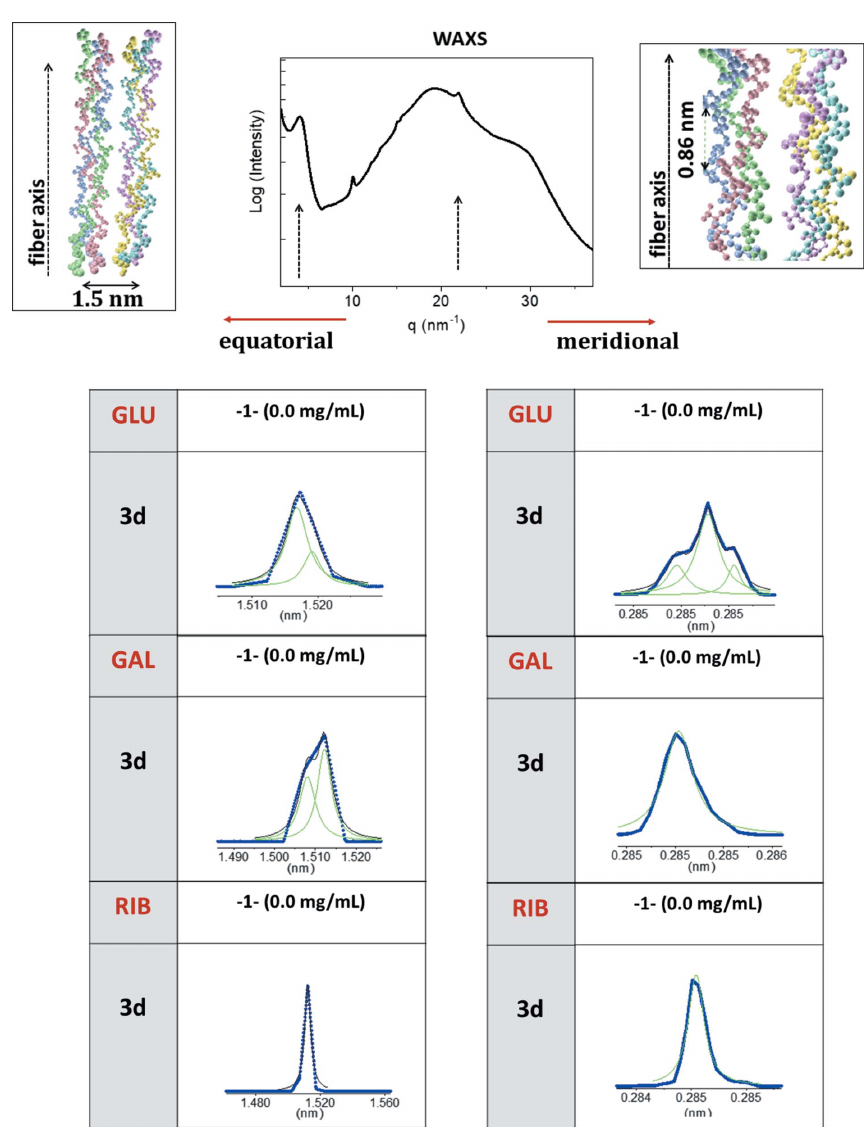
Figure 1 The above-molecular 1.5 and 0.86 nm distances are depicted in the molecular model of collagen, and the corresponding diffraction peaks at q = 2 (cid:3) / 1.5 nm and q = 2 (cid:3) /(0.86 nm/3) for the third order of 0.86 nm are marked in a typical azimuthally averaged WAXS profile (top). For each of the 4131 WAXS frames recorded for each sample, the position of these peaks has been determined, providing the statistical population for extracting a few characteristic structural parameters for each sample. Furthermore, histograms of the above-molecular peak positions mapped across samples immersed in the specified sugar concentrations (zero, i.e. control samples in this example) for three days (3 d) are shown (bottom). The histograms of the WAXS equatorial peak, corresponding to the 1.5 nm distance, are depicted in the left column and the histograms of the meridional peak, corresponding to the 0.86 nm distance, are depicted in the right